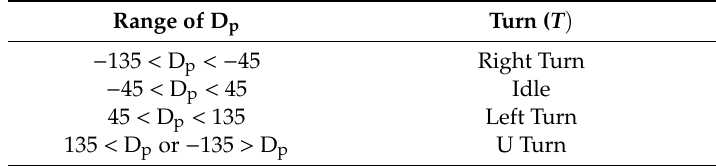
Figure 6. Overview of estimating the players’ movement directions. Table 1. Turn types based on the ranges of Dp.